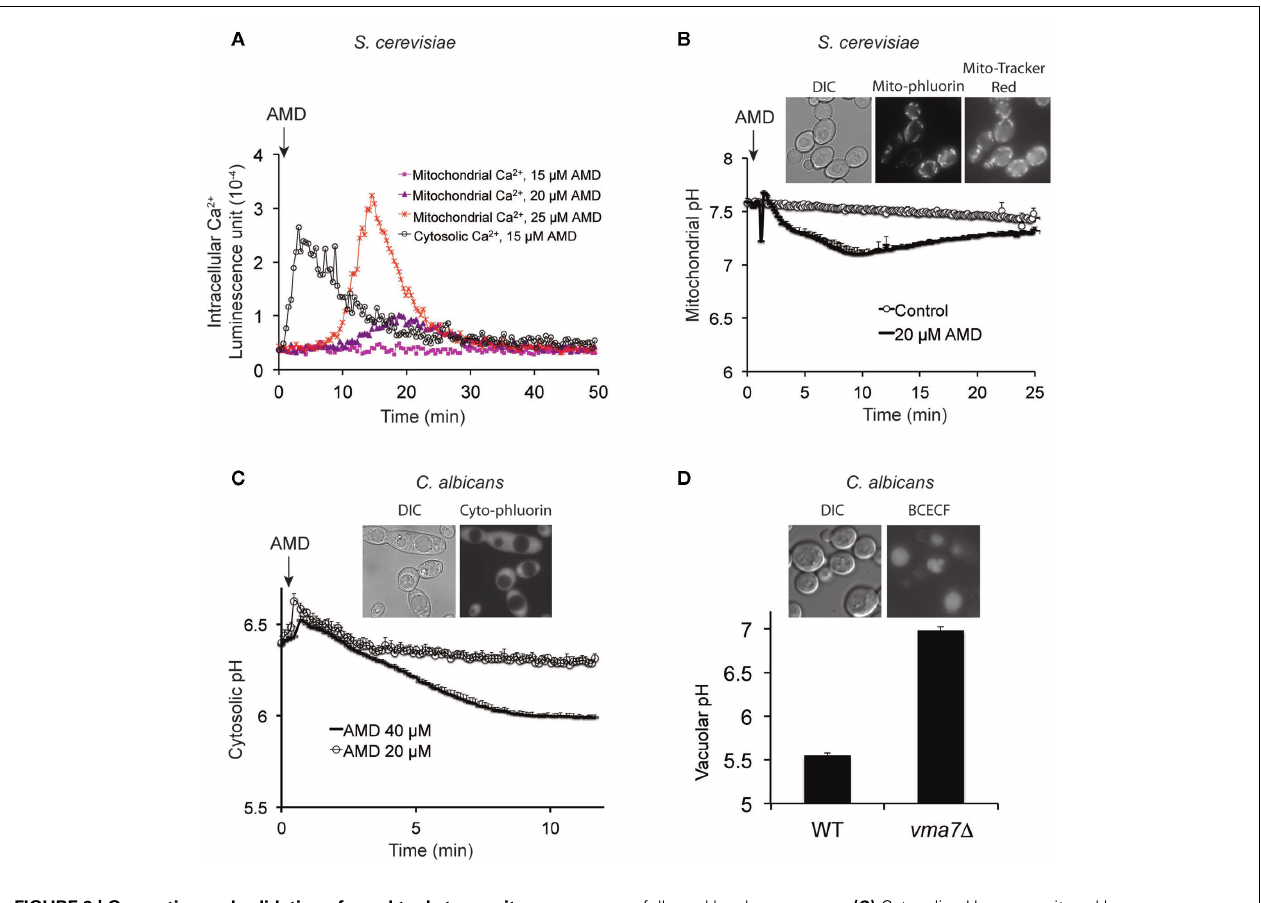
FIGURE 3 | Generation and validation of novel tools to monitor compartment-specific changes in Ca 2 + and pH. (A) Aequorin was targeted to cytoplasm or mitochondria in S. cerevisiae , by the addition of N-terminal signal sequence for the latter. Dose-dependent elevations of mitochondrial Ca 2 + are seen to follow cytoplasmic Ca 2 + fluxes upon amiodarone (AMD) addition (described previously, Gupta et al., 2003). (B) pH-sensitive version of GFP, pHluorin, was targeted to mitochondria where it colocalized with MitoTracker Red as seen in the inset. Addition of amiodarone acidified mitochondrial matrix, relative to control,